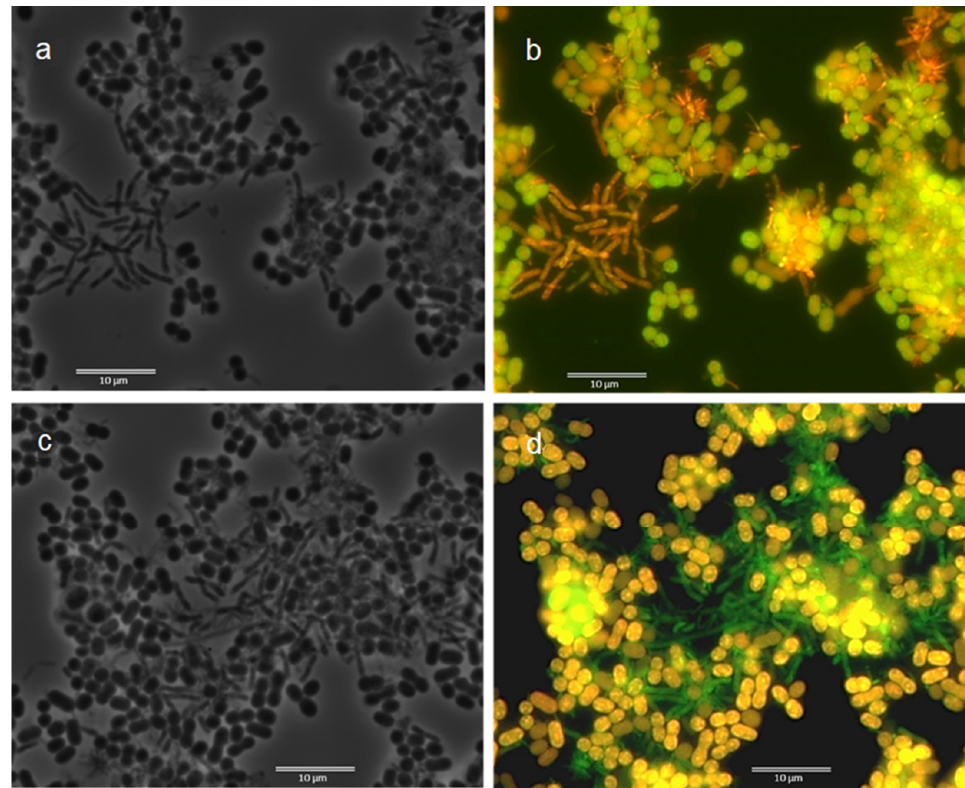
Figure 1. Microscopic images of culture S5 (synthetic medium, PF selection regime). ( a , c )—Phase- contrast. ( b )—Overlay image of bacteria hybridization with EUBmix and ALF969 (Alphaproteobacteria). ( d )—Overlay image of bacteria hybridization with EUBmix and GAM42a (Gammaproteobacteria). Results for EUBmix are in green (FITC label) and, for specific probes, orange (Cy3 label).